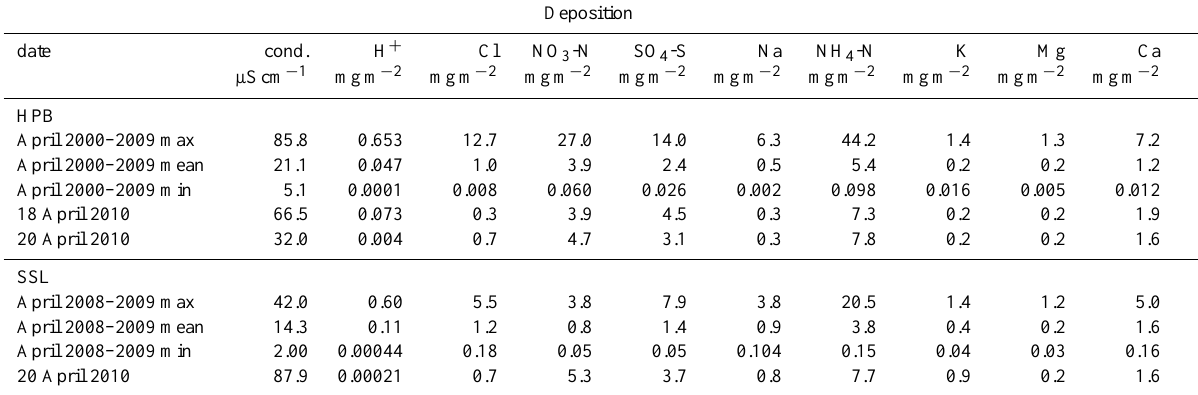
Table 3. Ion depositions and conductivities in precipitation (wet deposition) at Hohenpeissenberg (HPB) and at Schauinsland (SSL).